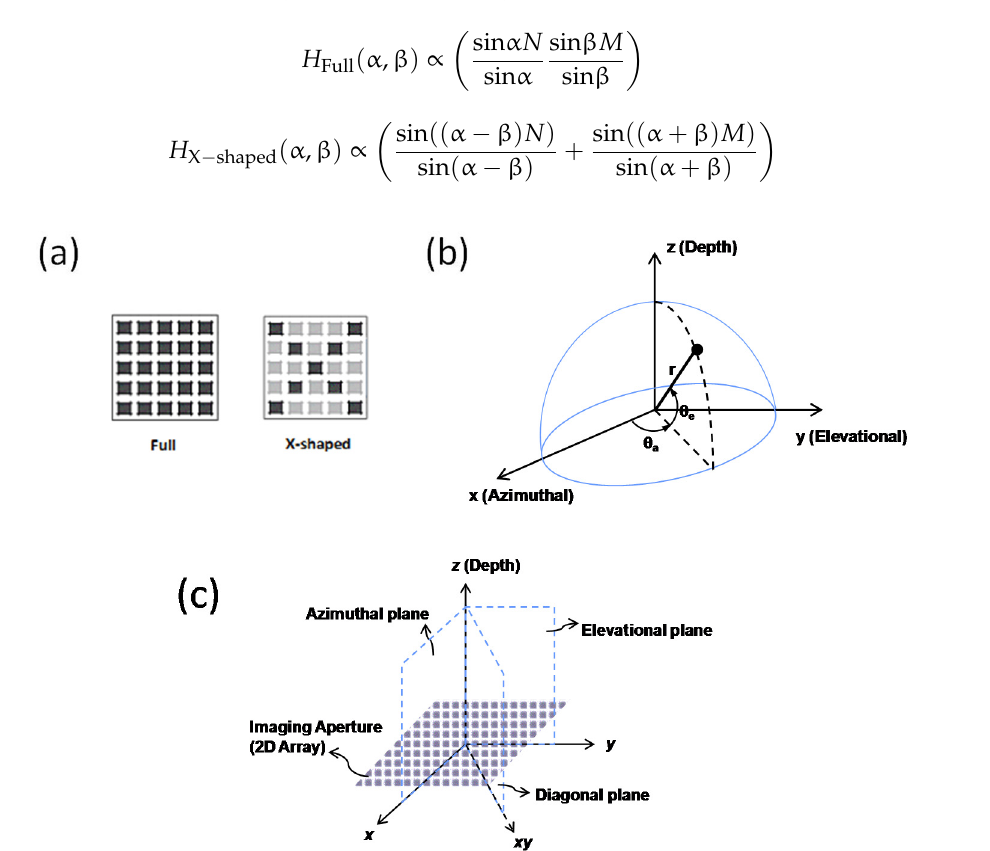
Figure 1. Volumetric ultrasound imaging: ( a ) full and cross-shaped sparse arrays, ( b ) geometry for the point spread functions (PSFs) of coarrays ( θ a = azimuthal angle and θ e = elevational angle), and ( c ) cross-sectional imaging planes.